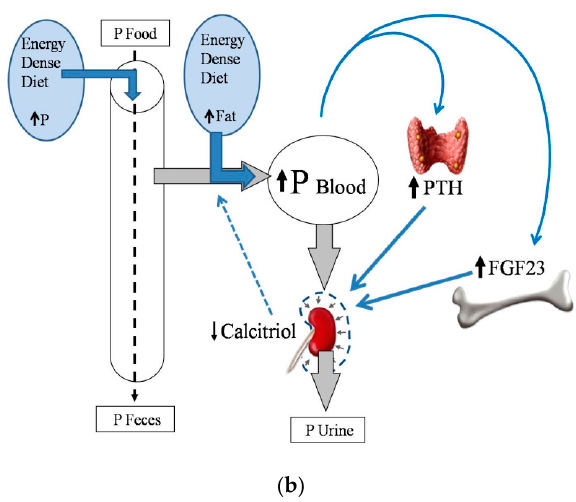
Figure 2. ( a ) Phosphate (P) balance in normal renal function; ( b ) Phosphate (P) balance in chronic renal failure. Fibroblast growth factor 23: FGF23; Parathyroid hormone: PTH.